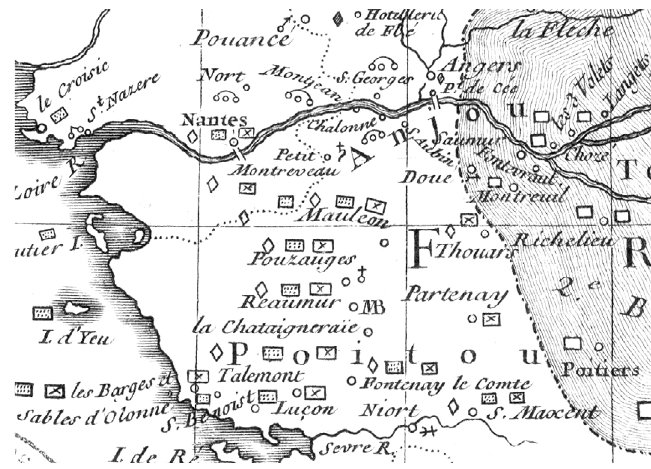
Fig. 6. A part of the map by J.-É. Guettard, 1751 presenting natural resources in the area between Loire River and Sevre